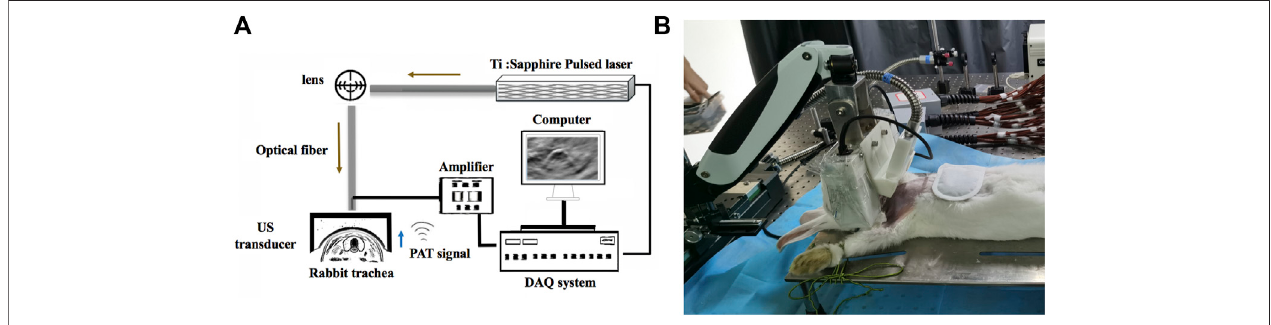
FIGURE 1 | Schematic of the PAT/MSOT system for rabbit airway imaging. (A) The schematic of the hardware components employed, including the pulsed laser, optical fi ber, ultrasound (US) transducer, computer, data acquisition (DAQ) system, and ampli fi er. (B) photograph of our system being utilized in a rabbit model.